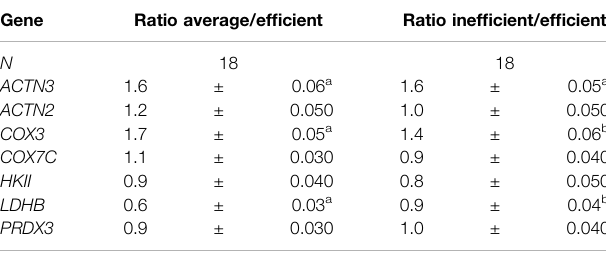
TABLE 7 | Relative mRNA expression of selected genes by qRT-PCR analysis.